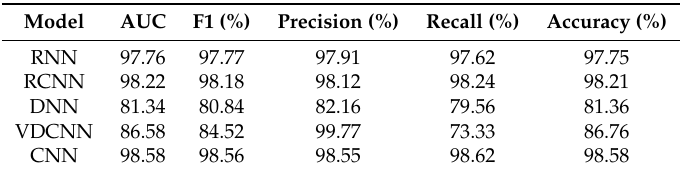
Table 7. Evaluation of FG2 on D2 with different deep learning models.